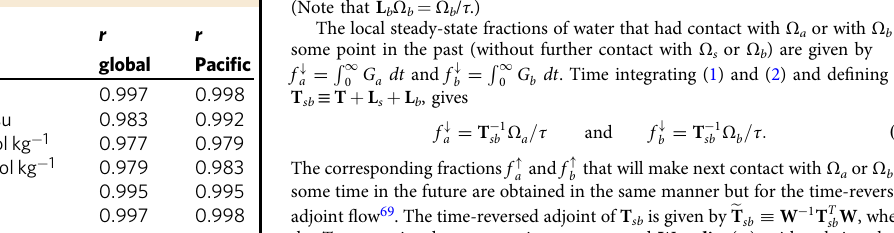
Table 1 OCIM2-48L Model – Observation RMSE and Pearson ’ s r for data-assimilated circulation